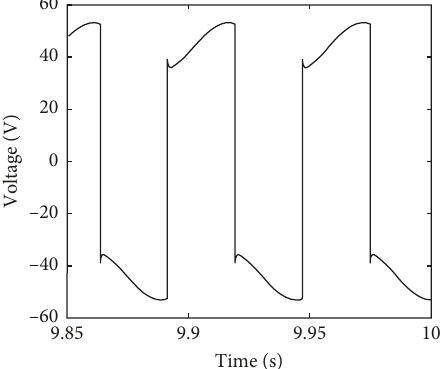
Figure 6: Output voltage waveform of a piezoceramic using the SP- OSSHI circuit.